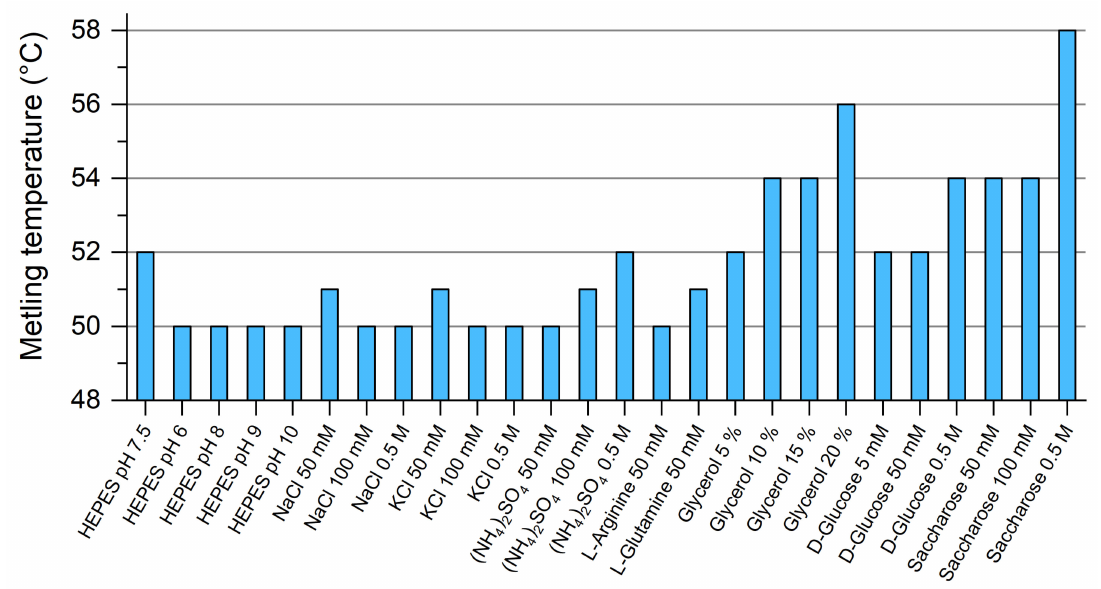
Figure 4. B7-H6 is stabilized by glycerol and saccharose addition. Di ff erential scanning fluorimetry was used to analyze changes in protein melting temperature when adding various